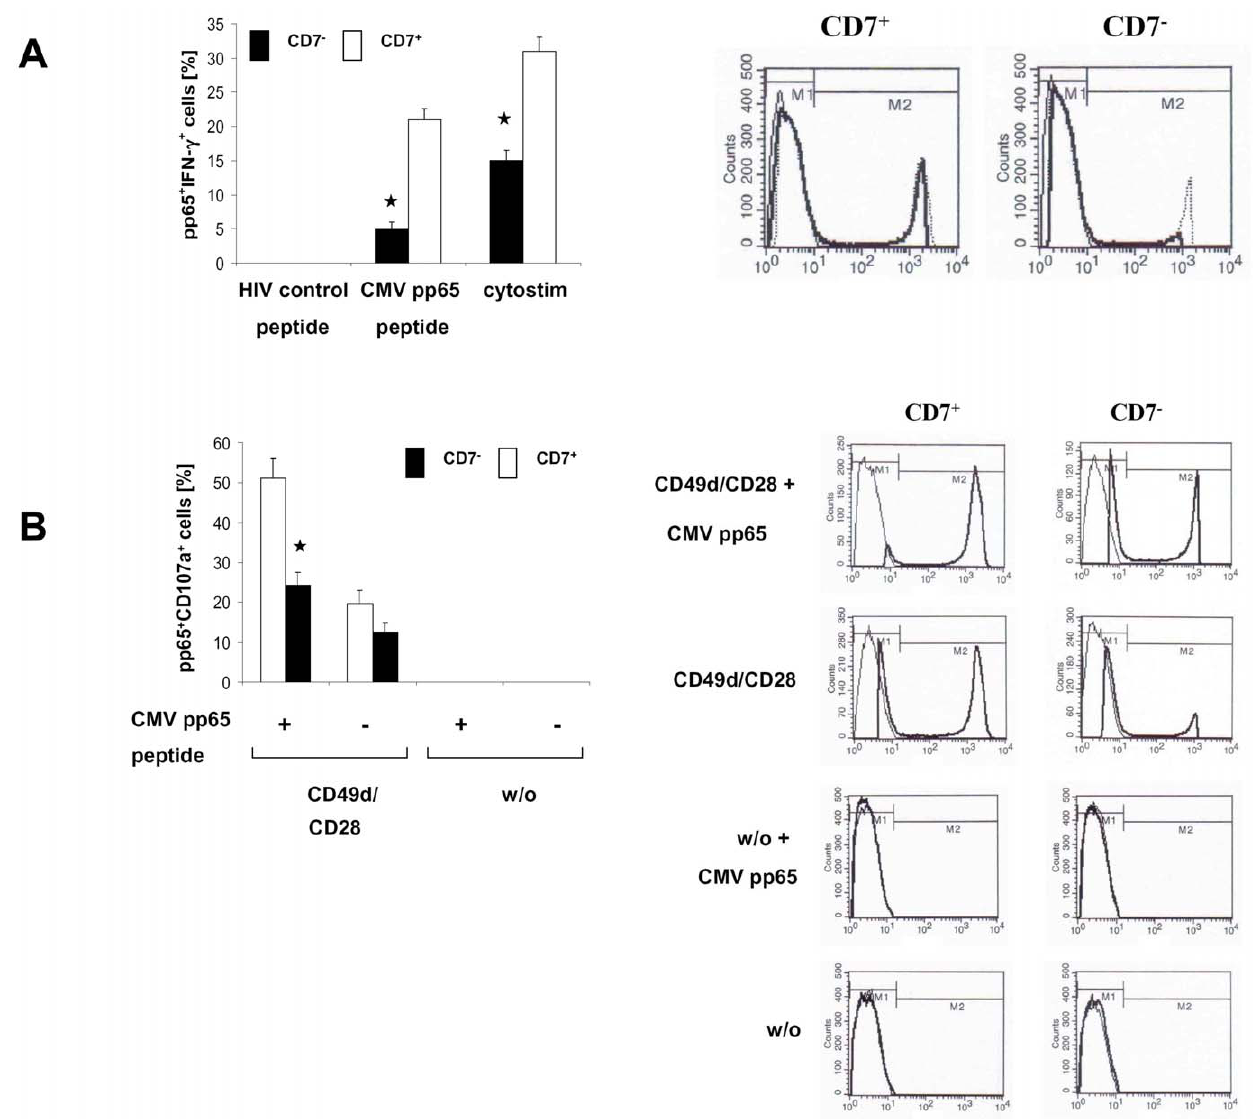
Figure 1. CMV-specific, late-stage T cells are hypo-responsive upon TCR stimulation compared to intermediate-stage T cells. (A) Freshly isolated PBMC’s from CMV patients were activated by incubation with CMV pp65 peptide or for control with the HIV peptide or Cytostim, respectively, for 6 hrs. CMV-specific cells were identified by staining them with the PE-conjugated MHC tetrameric complexes and mAbs specific to CD8, CD7, CD45RO and subsequently recorded for IFN-gamma production by staining the with anti-human IFN-gammamAb. The number of tetramer-positive cells of the CD7 2 and CD7 + cells of the CD8 + CD45RO + subset with and without IFN-gammaproduction was recorded by flow cytometry. Histograms of one representative donor from five CMV patients is shown. Overlays of control peptide stimulated (thin line), Cytostim- activated (dotted line), and CMV peptide-stimulated (bold line) cells are shown. (B) CD107a was monitored by flow cytometry of CMV-specific CD8 + CD45RO + T cells of the CD7 2 and CD7 + subsets after or without CD49d/CD28 stimulation in presence or absence of CMV peptide. Histograms of one representative donor from five CMV patients is shown (CD107a: bold line; isotype control: thin line). Data in Fig. 1 A & B represent mean values 6 standard error of the mean (SEM) of five donors and were compared using a paired t-test. * p ,